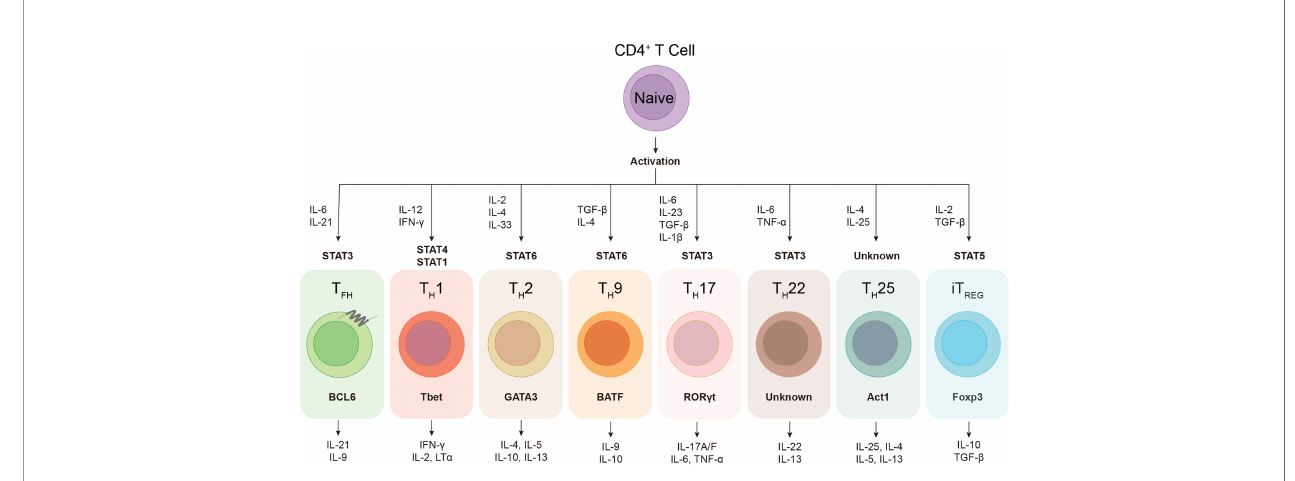
FIGURE 1 | The plasticity of helper CD4+ T cells. Upon activation, naïve CD4 + T cell can differentiate into various subsets of T helper lineages, regulated by certain cytokines and activated signal transducers and activators of transcription (STATs). Each CD4 + helper lineage has the speci fi c lineage-de fi ning transcription factors, e.g. BCL6 in T FH cell, and the characteristic pro fi le of cytokine production, e.g. IL-21 and IL-9 in T FH